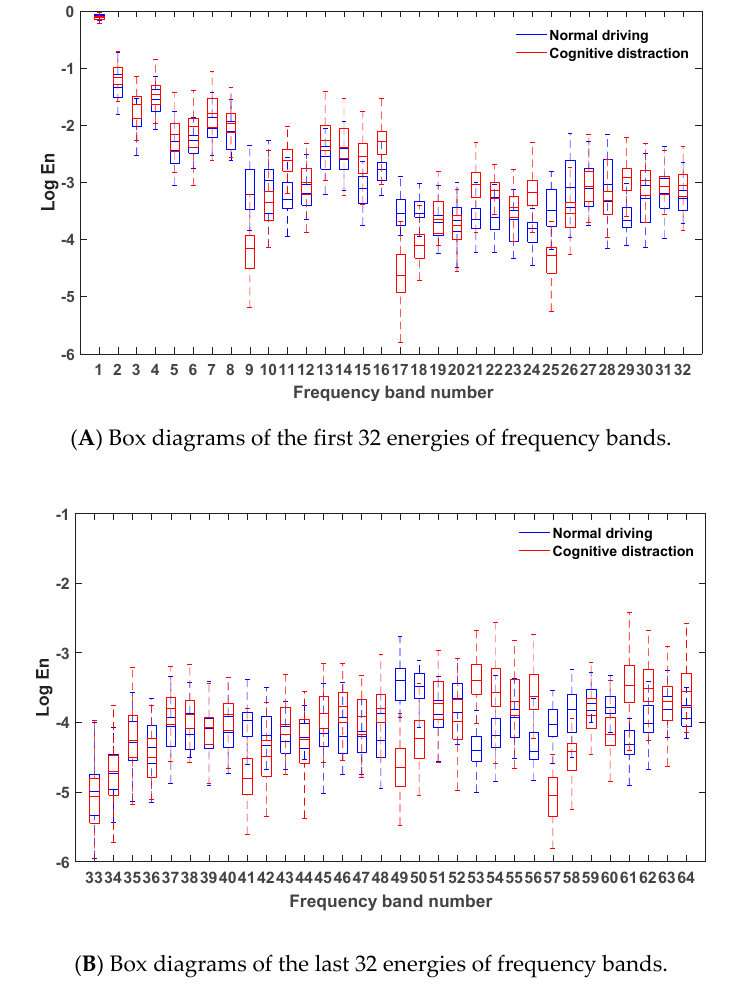
Figure 8. Box diagrams of the energies of the frequency bands under different driving states.